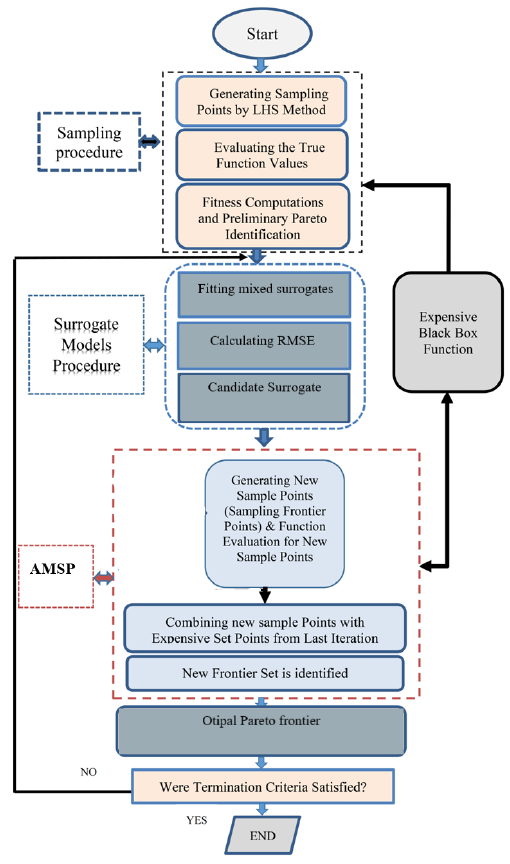
Figure 1. Flowchart of the Proposed approach (AMSP).